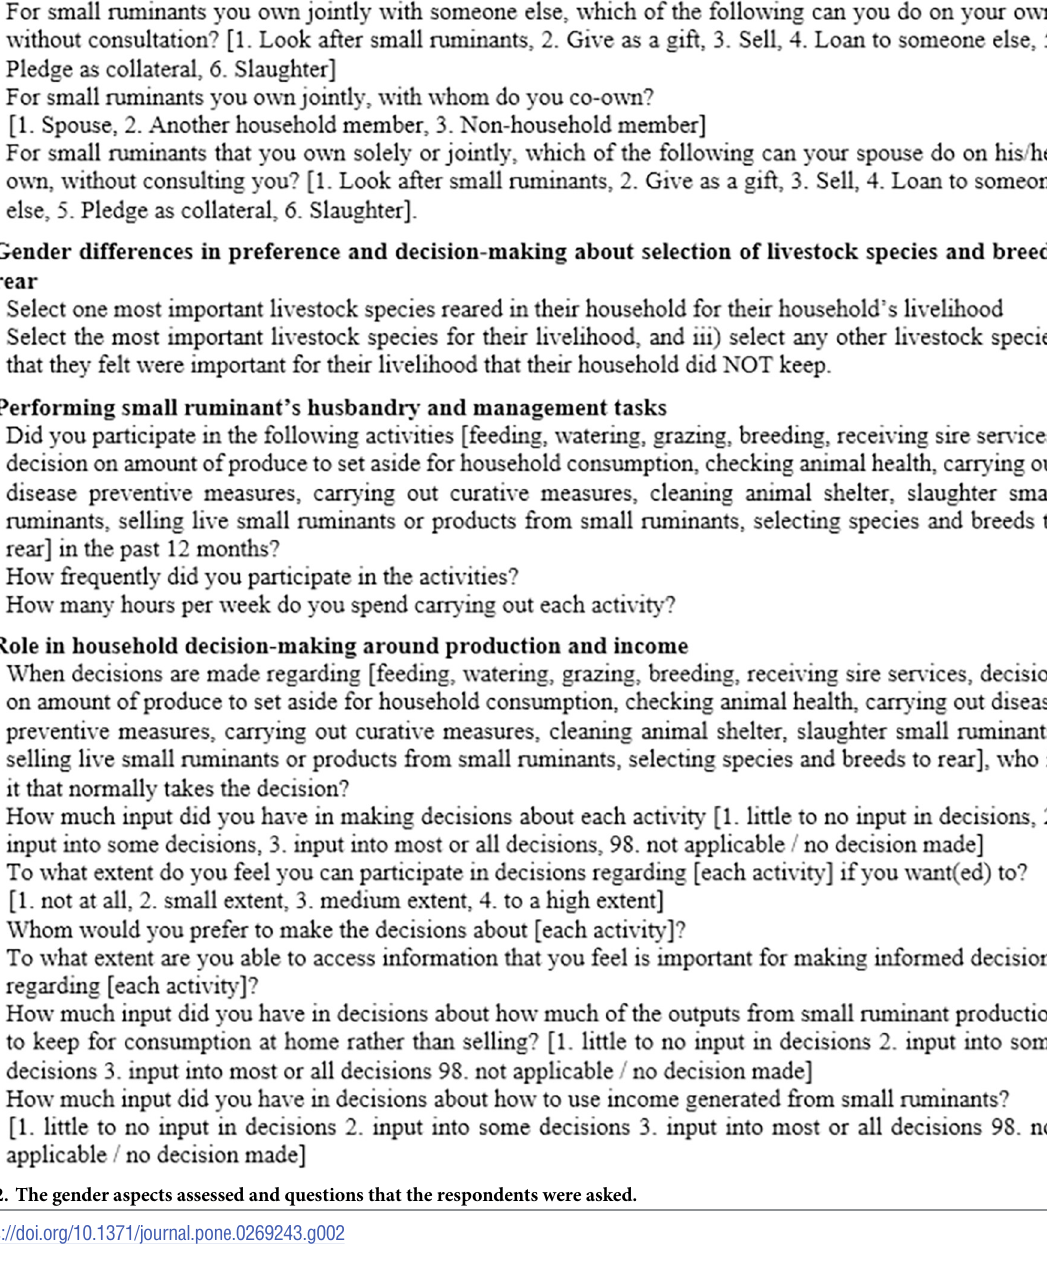
PLOS ONE | https://doi.org/10.1371/journal.pone.0269243 August 4,